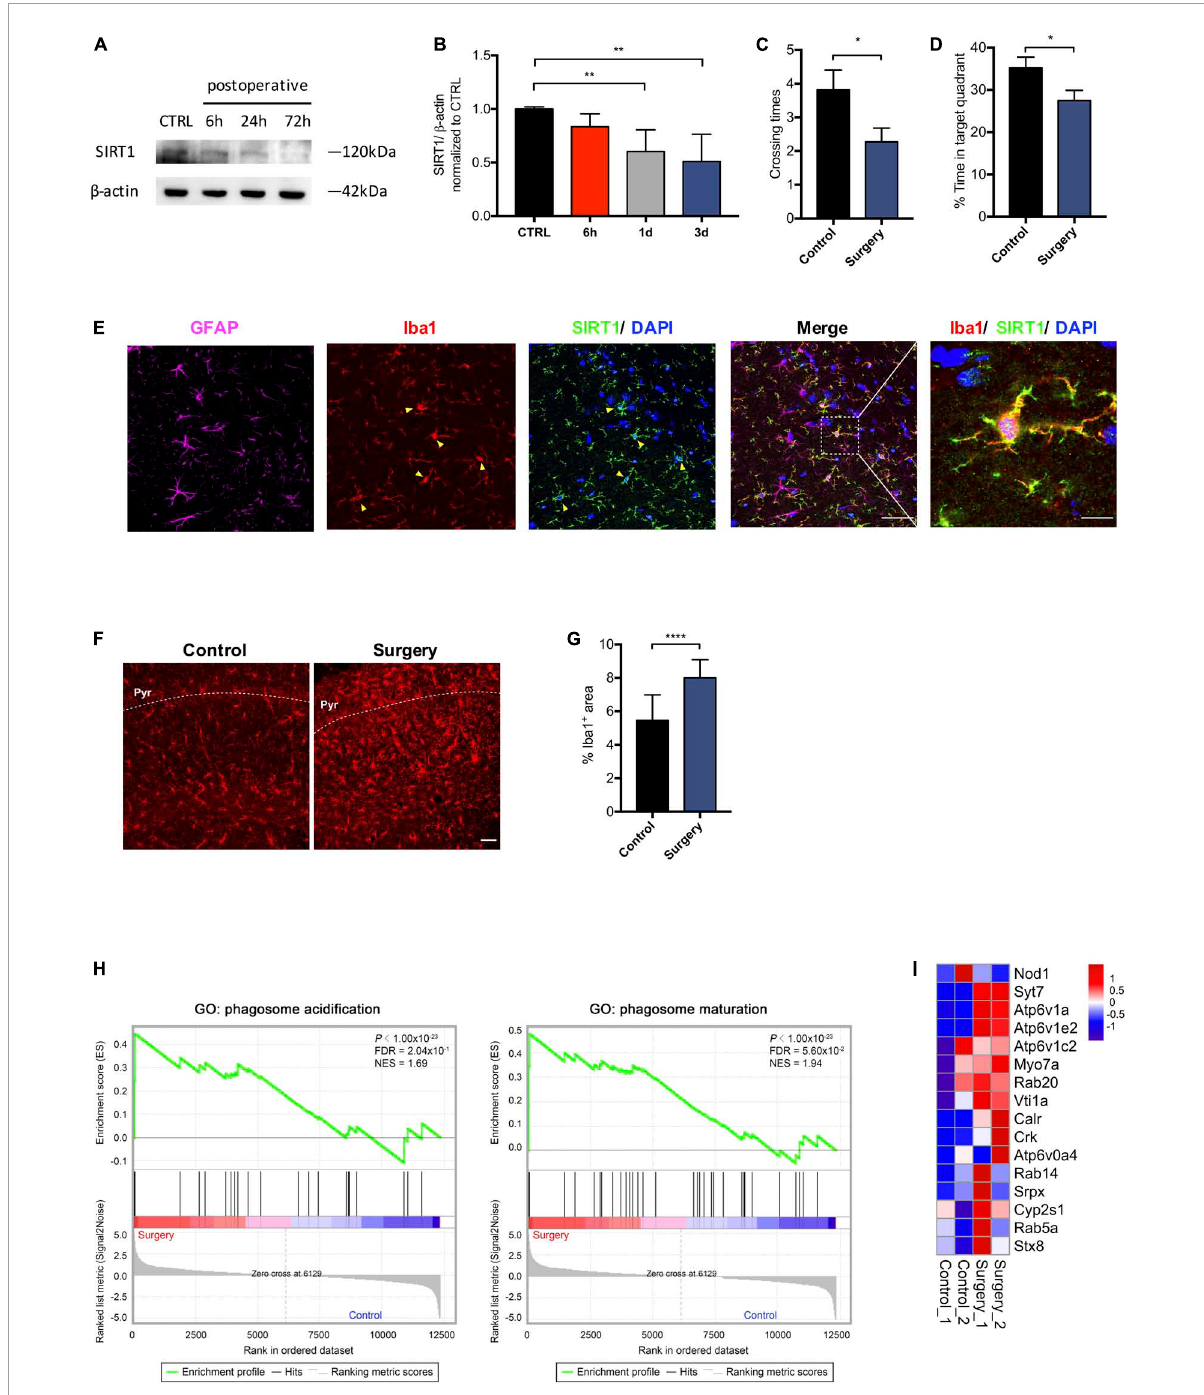
FIGURE3 Anesthesia and surgery induces microglial activation in the hippocampus. (A) Time course of SIRT1 expression. (B) Qualification of panel A . One-way analysis of variance (ANOVA) with Dunnett post-hoc test. Mean ± SD. (C) Crossing times of the platform area in probe trials on the third after surgery. n = 11 per group. Two sided t -test. Mean ± SEM. (D) Percentage of time spent in target quadrant in probe trials on the third after surgery. n = 11 per group. Two sided t -test. Mean ± SEM. (E) Representative images of SIRT1 co-labeled with antibodies to cell-type-specific markers, n = 5. Left panel scale bar, 50 µ m; right panel scale bar, 10 µ m. (F) Representative images of Iba1 (Red) labeling in the CA1. Scale bar, 50 µ m. Pyr, pyramidal cell layer. (G) Qualification of panel F , n = 5 per group. Two sided t -test. Mean ± SD. (H) Gene set enrichment analyses (GSEA) of phagosome acidification (left) and phagosome maturation (right) in surgery versus control group. NES, normalized enrichment score; FDR, false discovery rate. (I) Heatmap representation of differential expression for phagosome acidification and phagosome maturation genes. * p < 0.05; ** p < 0.01; **** p <